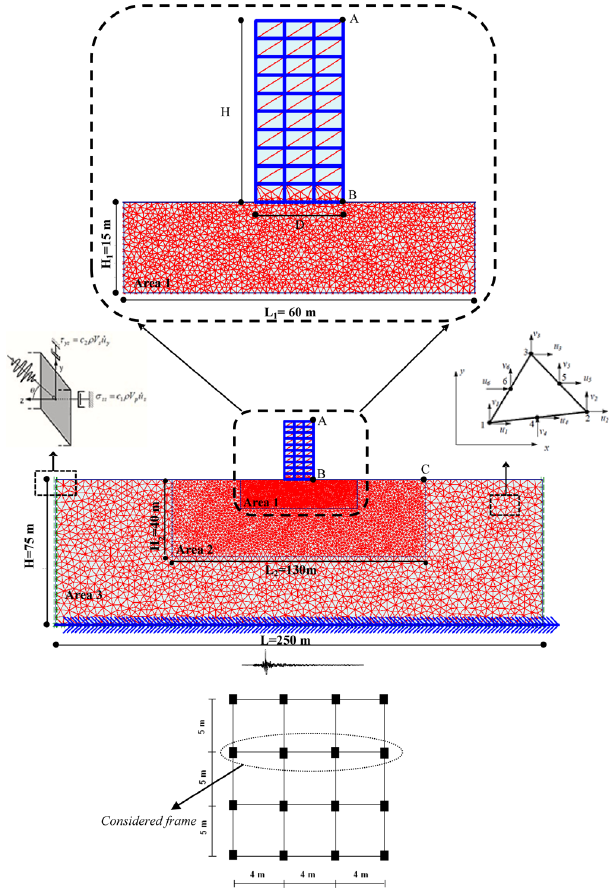
Fig. 1. Finite element mesh considered for the soil-structure inter- action